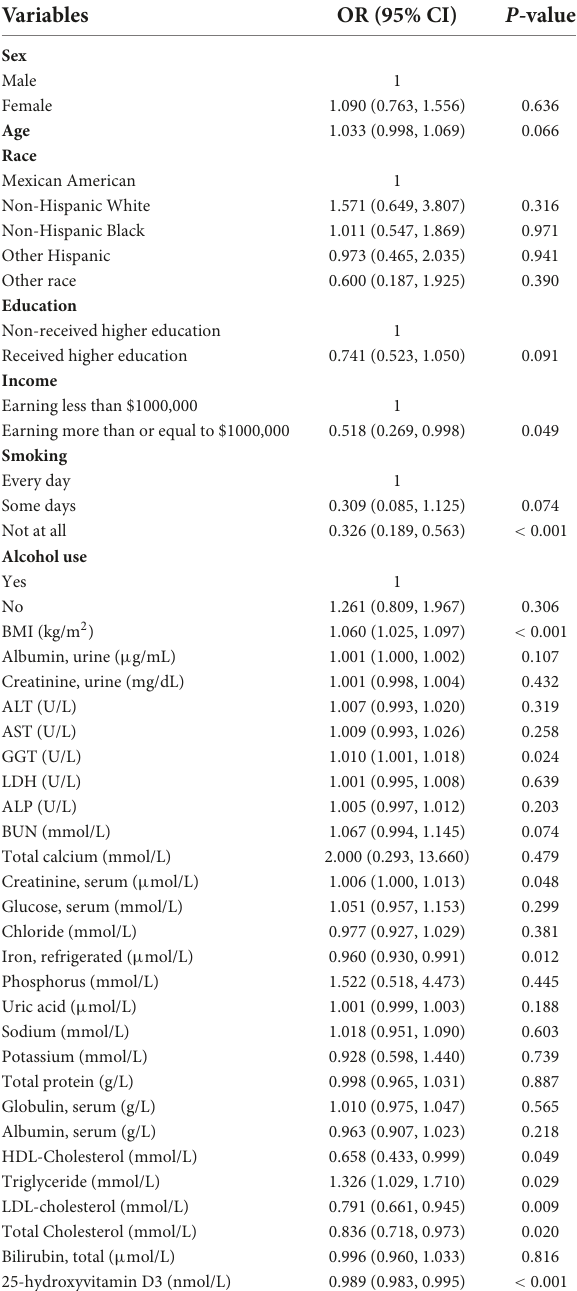
TABLE 2 Univariate analysis for